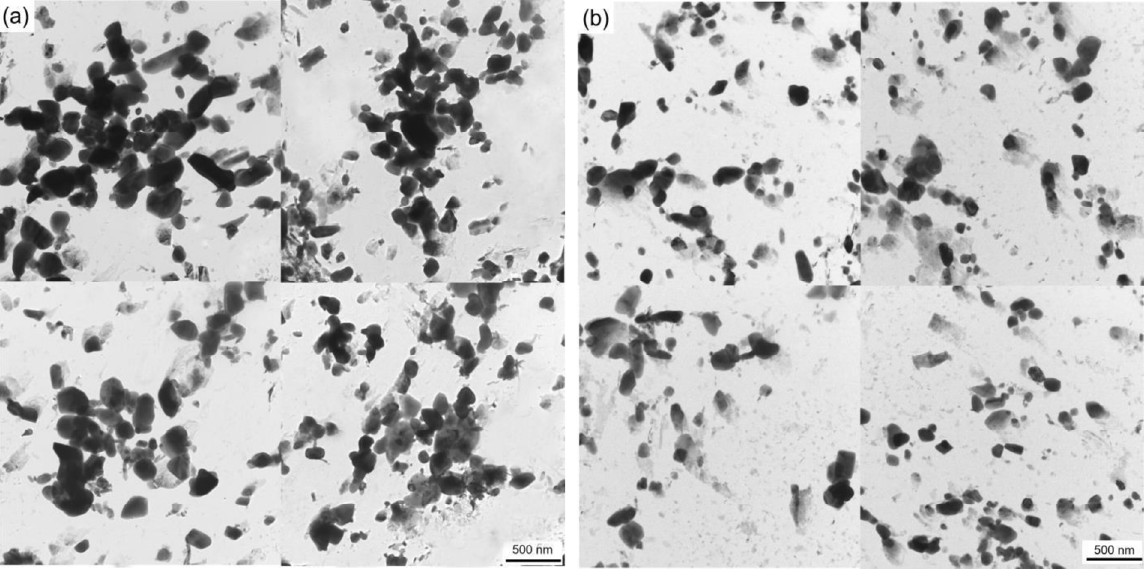
Figure 9. TEM micrograph of tested steels after tempering for 64h at 650 °C: ( a ) 0.3 Si; ( b ) 1.0 Si.